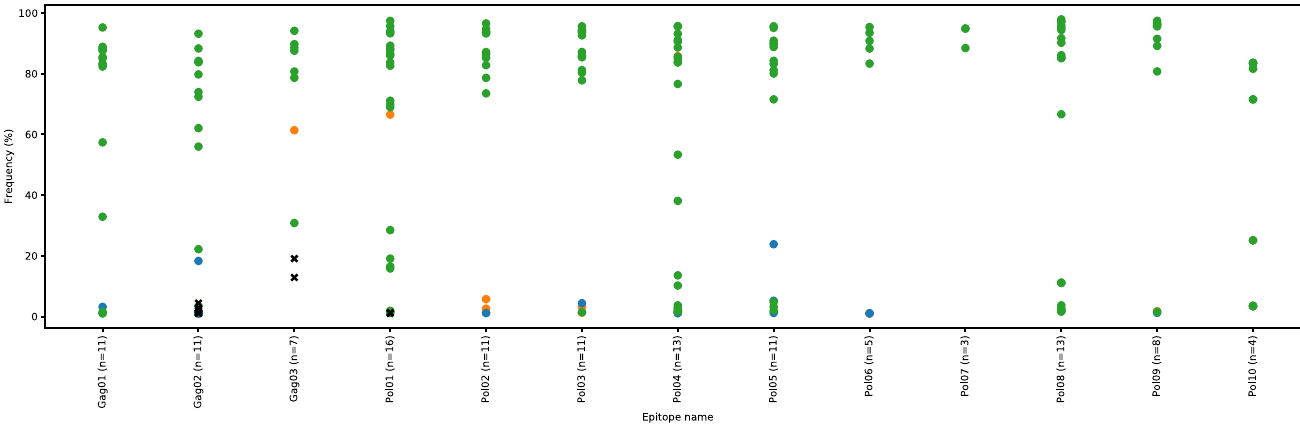
Fig 1. Plot representation of HIV epitope variants per patient according to their MHC IC 50 score. For each of our conserved epitopes, one dot represents one patient’s HIV epitope variant according to i) its percentage of frequency calculated from NGS results and ii) its ability to bind the corresponding HLA groove. The color displays the MHC IC 50 score: green IC50 < 50 nM; blue 50 < IC 50 < 500 nM and orange IC 50 > 500 nM. The crosses indicate variants with stop codons.